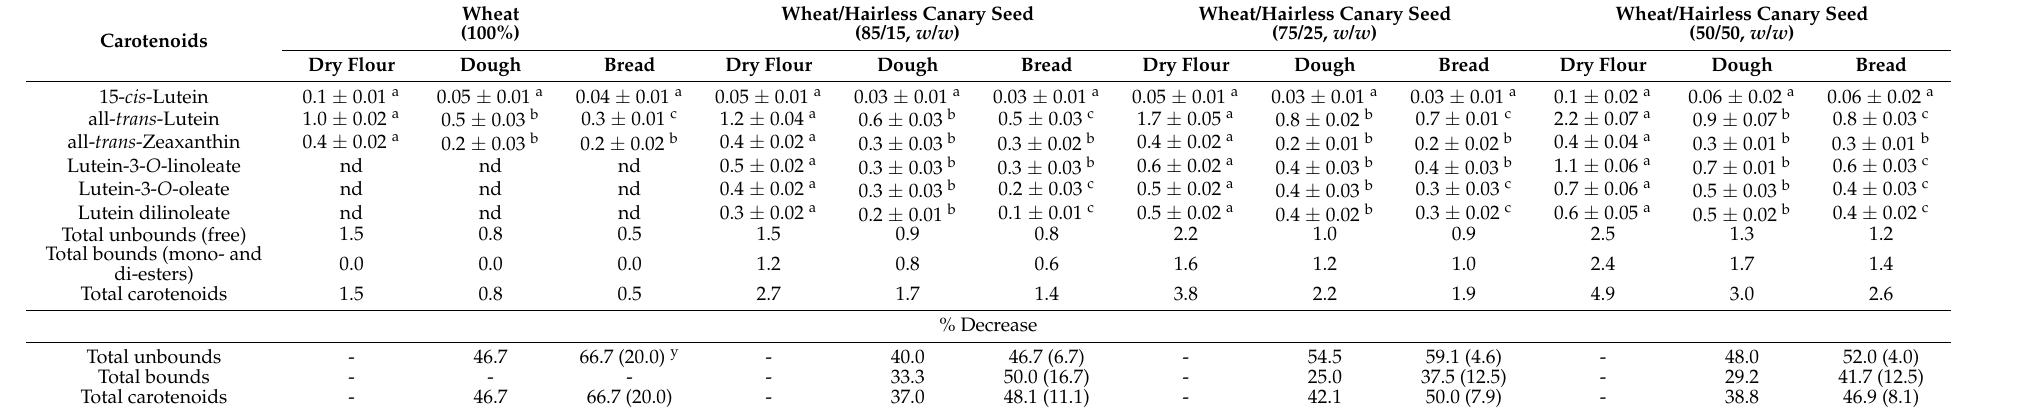
Table 3. Content of major carotenoids in bread formulations and products ( µ g/g) and the impact of baking process on carotenoids (% decrease) x